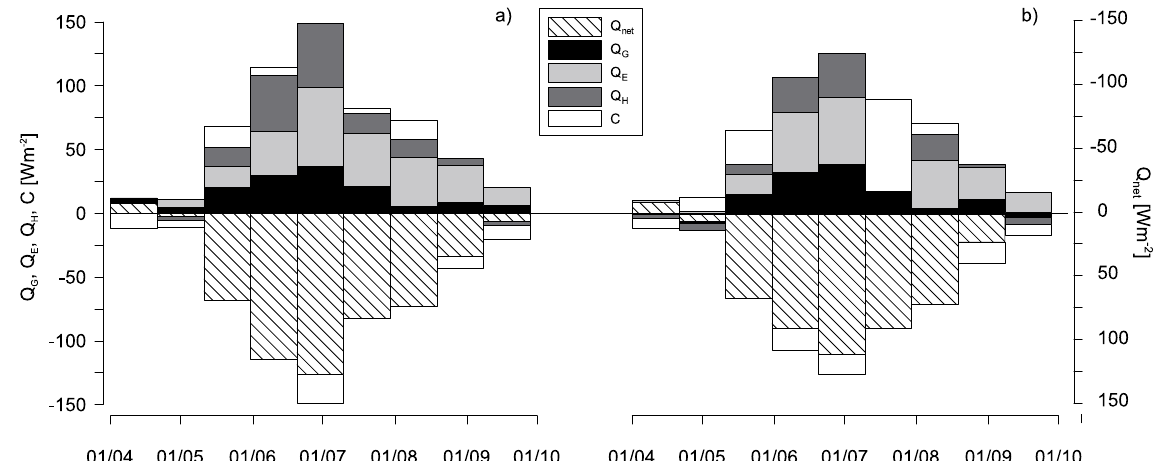
Fig. 3. The energy balance of (a) 2007 and (b) 2008. Heat fluxes are averaged over 20 days, and data gaps in the latent heat fluxes are filled by modeled values. For the visualization, the averaging intervals of 20 days are found to be a good compromise between temporal resolution and data density. The fraction of modeled latent heat fluxes is 68% in 2007 and 8% in 2008. Averages are discarded if the data density is less than 60%. Note that the net radiation is displayed on a second y-axis with respect to illustration. estimated by means of visual inspection of daily photographs taken automatically from a 2 m mast at the measurement